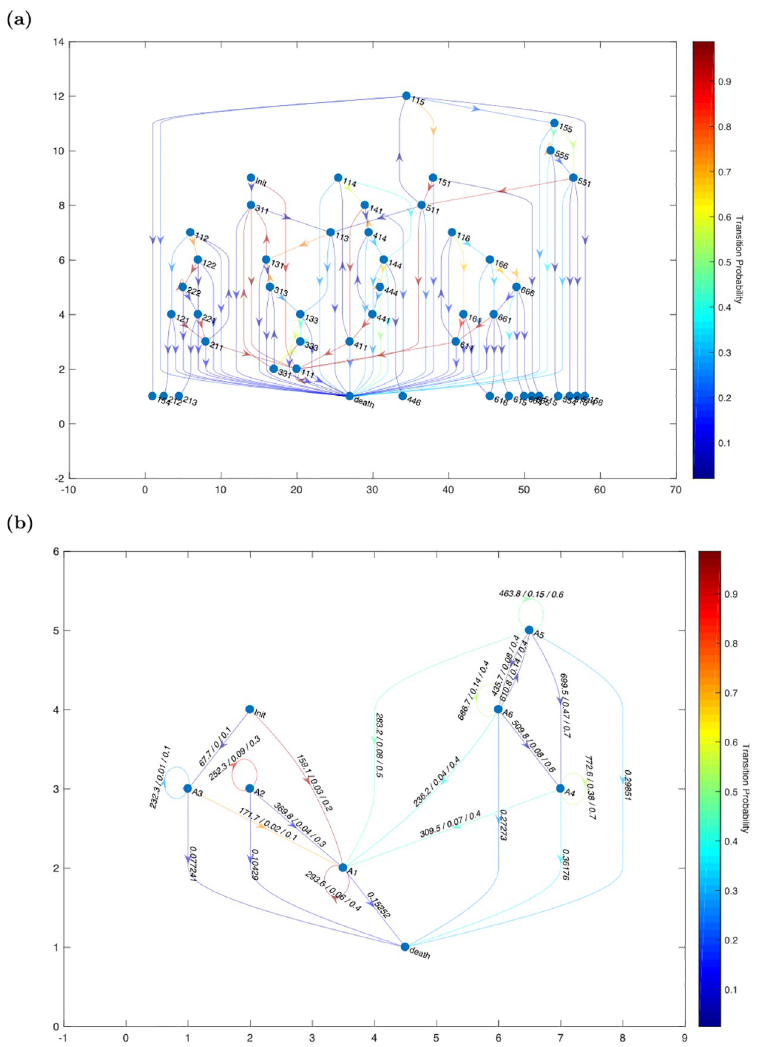
Fig 6. (A) Third-order transition graph: Edges approaching red in color indicate higher transition probabilities, and edges approaching black indicate lower transition probabilities. (B) First-order transition graph. Averaged fluids, maximum dosage of vasopressor, the probability of using mechanical ventilator, and the mortality rate are shown on the